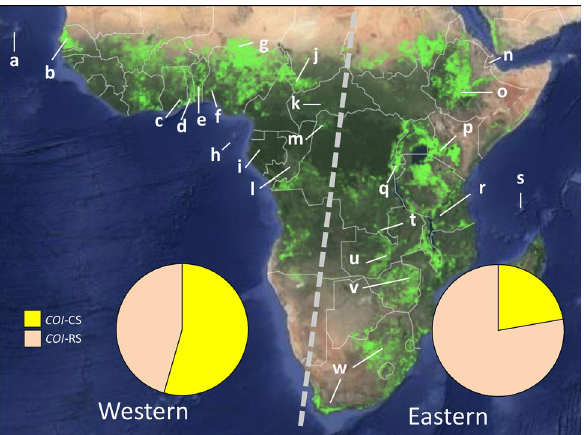
Figure 1. Map of croplands in sub-Saharan Africa with locations of collection sites that are detailed in Table 1. In light green are the locations of agricultural crop areas identified by satellite imagery at 30-m resolution, with the map obtained from https:// cropl ands. org/ app/ map 30,31 . Dashed grey line separate western and eastern collection sites. Pie charts describe the proportion of COI -CS and COI -RS haplotypes in each